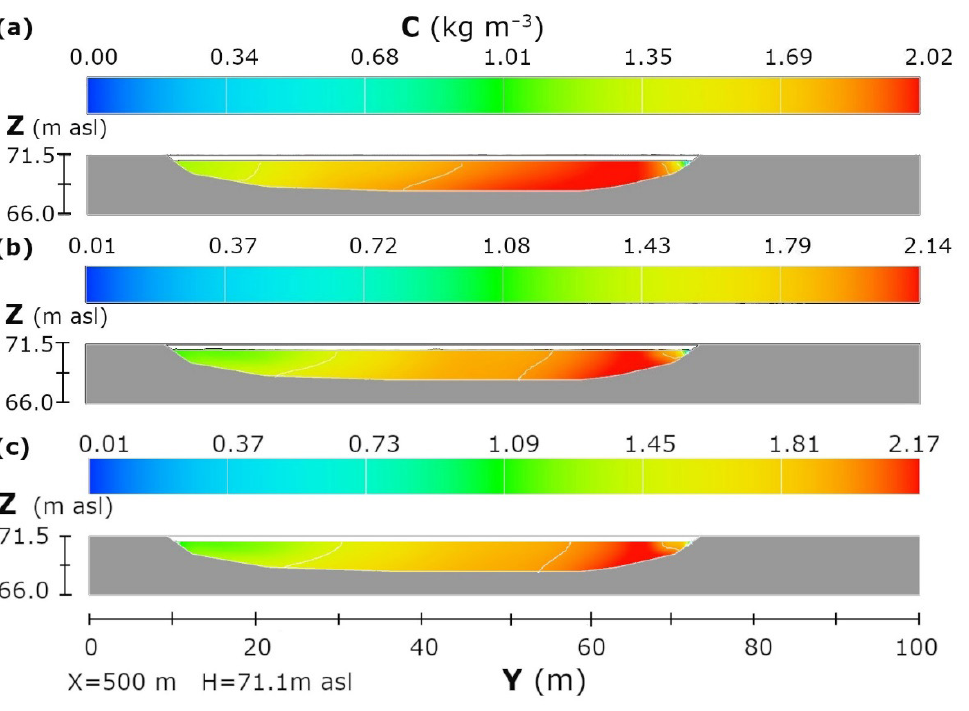
Figure 7: Image of the brine concentration in the cross section at the end of the model: (a) grid 1 × 1 × 0.5 – 500,000 elements, (b) grid 0.67 × 0.67 × 0.31 – 1,912,500 elements and (c) grid 0.5 × 0.5 × 0.25 – 4,400,000 elements.